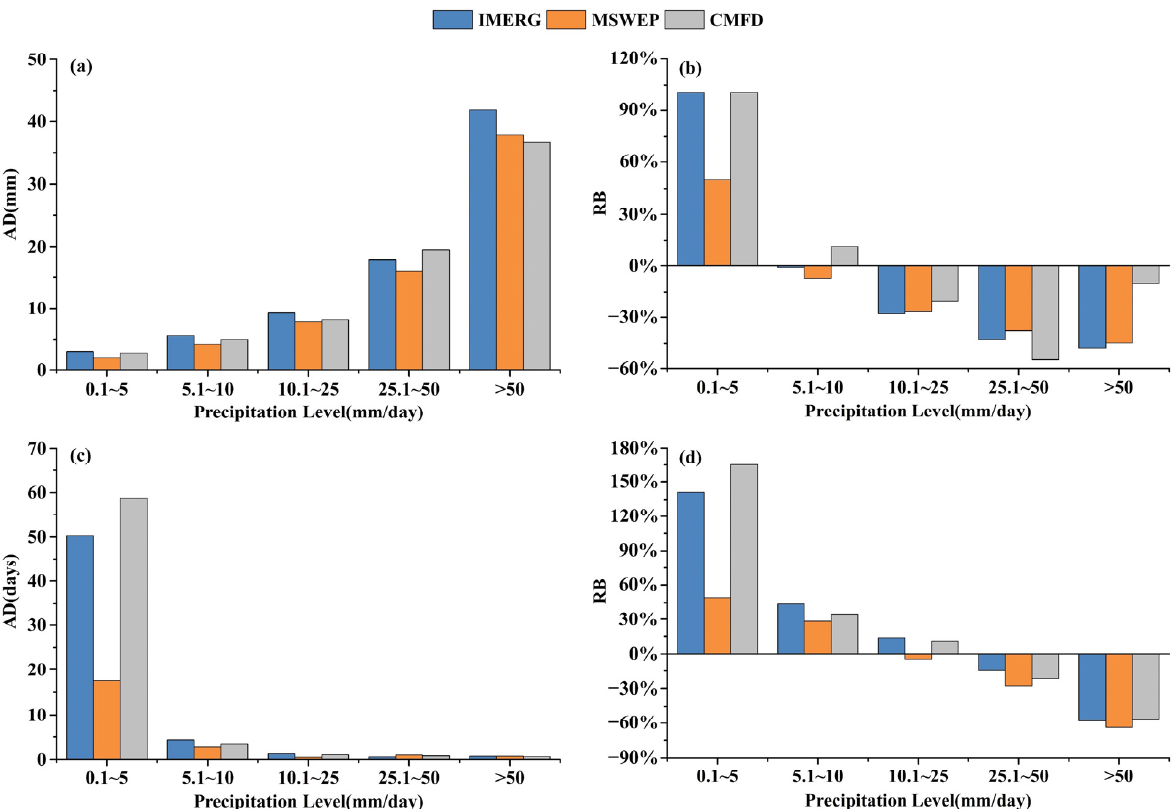
Figure 6. Absolute and relative deviations between the satellite-derived precipitation data and rainfall station data for different precipitation levels: ( a ) AD of precipitation, ( b ) RB of precipitation, ( c ) AD of number of precipitation days, and ( d ) RB of number of precipitation days.